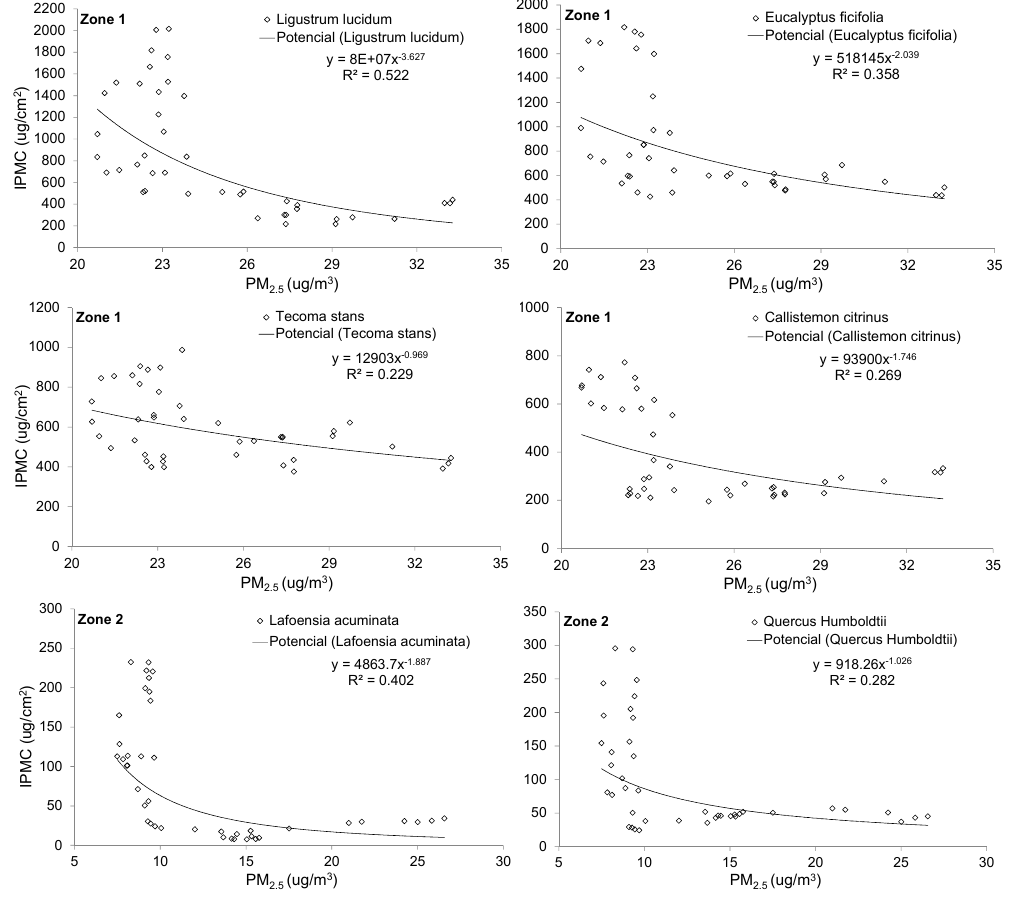
Figure 3. Monthly IPMCs and PM 2.5 concentration in air quality stations. Zone 1: Ligustrum lucidum , Eucalyptus ficifolia , Tecoma stans , and Callistemon citrinus . Zone 2: Lafoensia acuminata and Quercus Humboldtii .